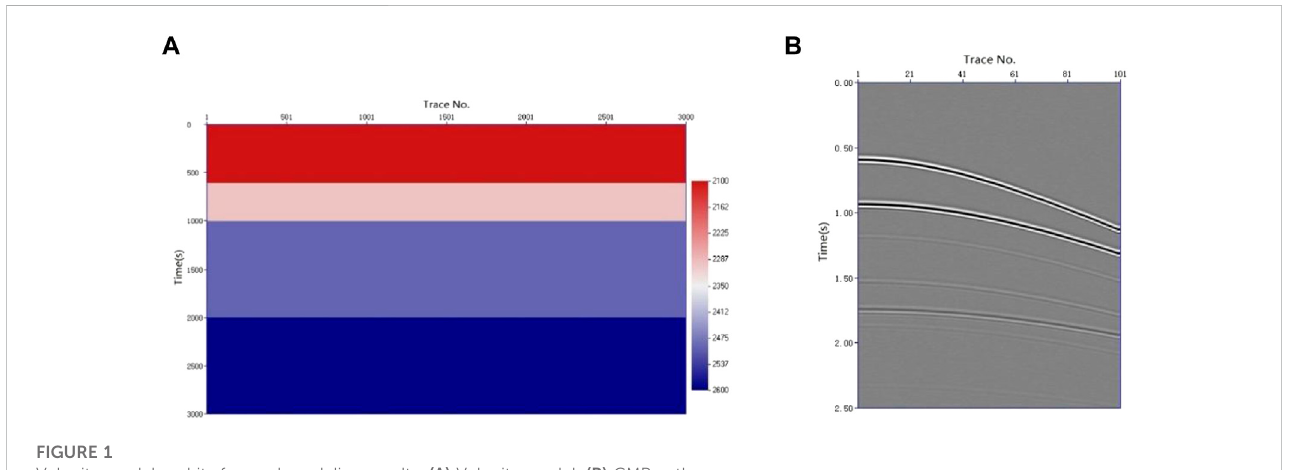
FIGURE 1 Velocity model and its forward modeling results. (A) Velocity model. (B) CMP